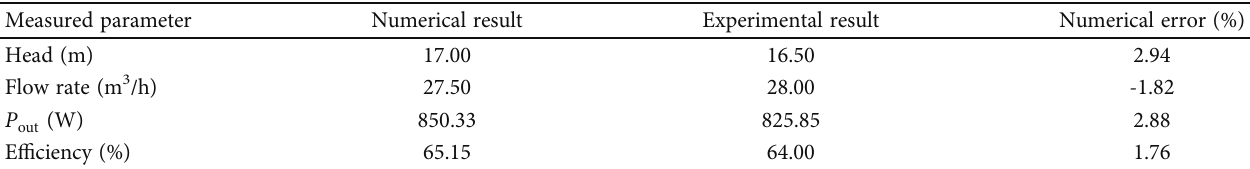
Table 4: The deviation of CFD results at the